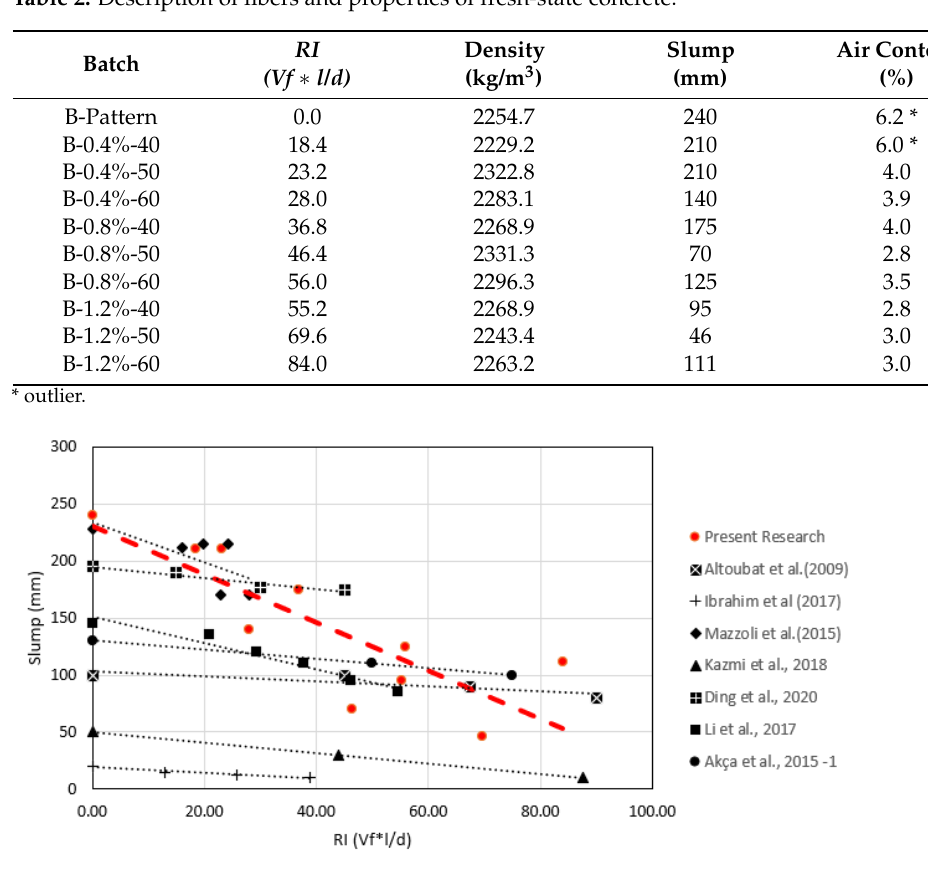
Table 2. Description of fibers and properties of fresh-state concrete.